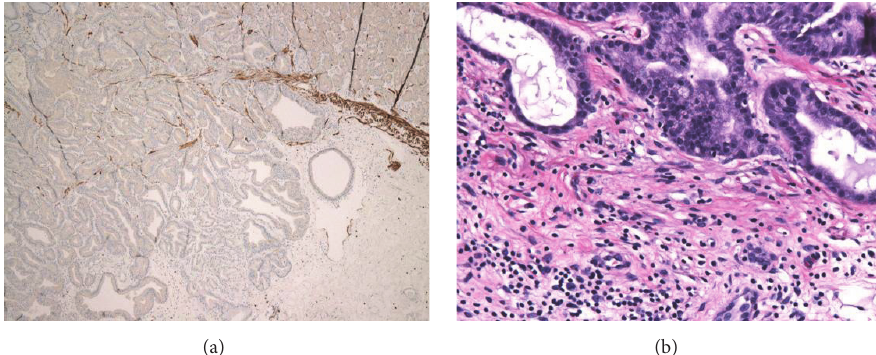
Figure 5: Submucosal invasion with complete disruption of the muscularis mucosae (a) (desmin immunostain × 40) and mild lymphocytic and fibroblastic stromal reaction (b) (H&E × 200).